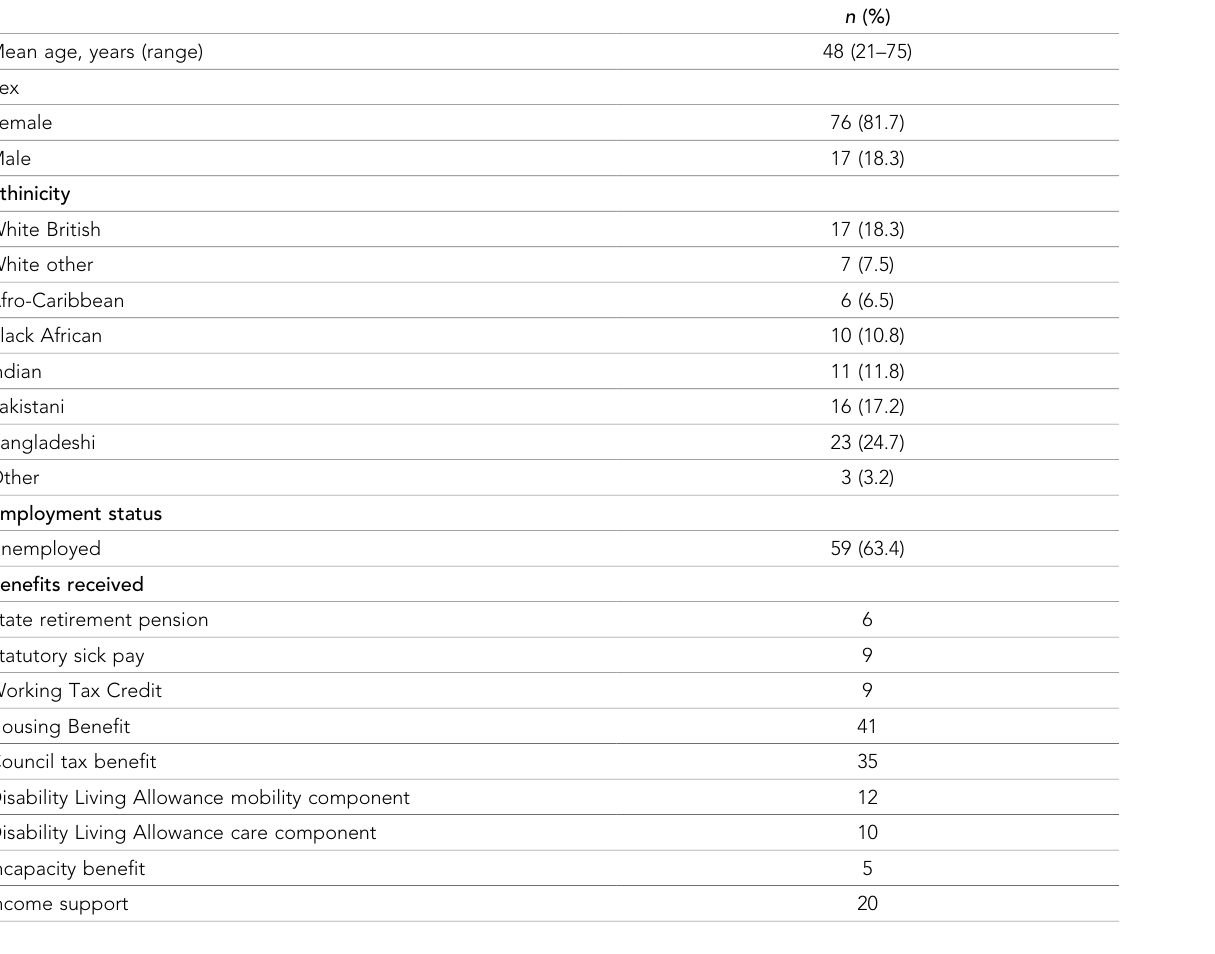
Table 1. Participants’